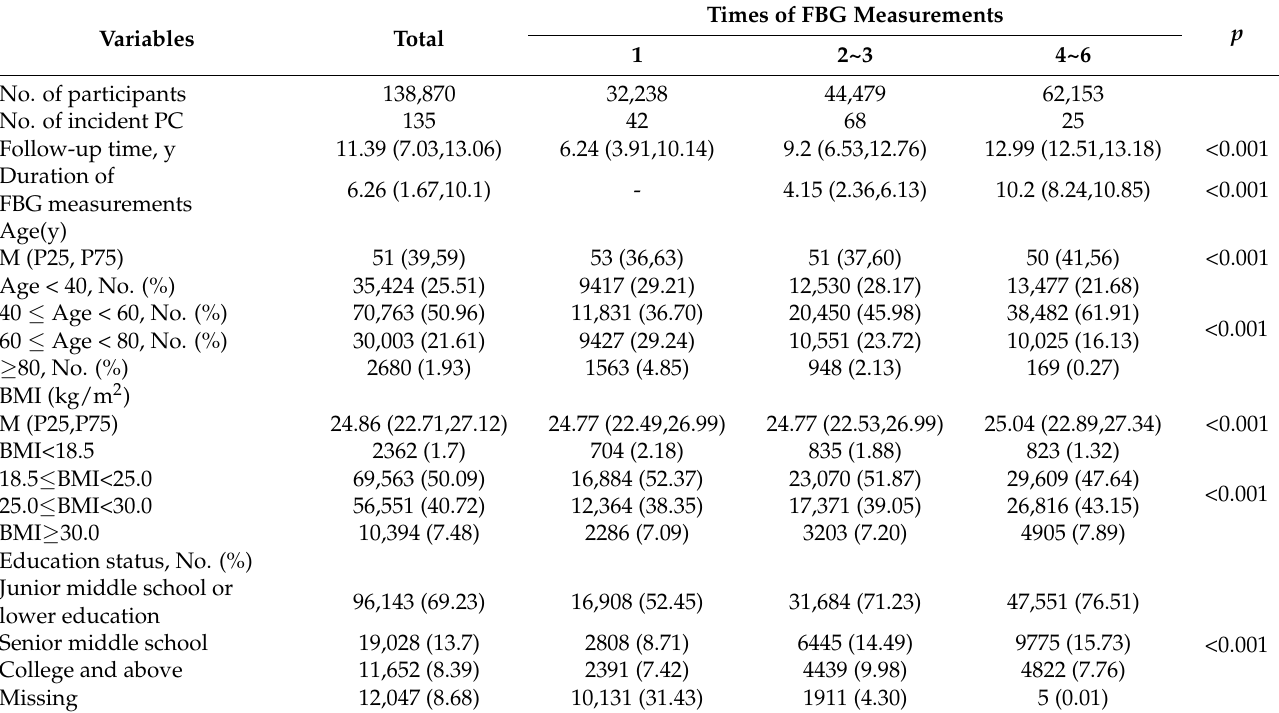
Table 1. Characteristics of participants included in the